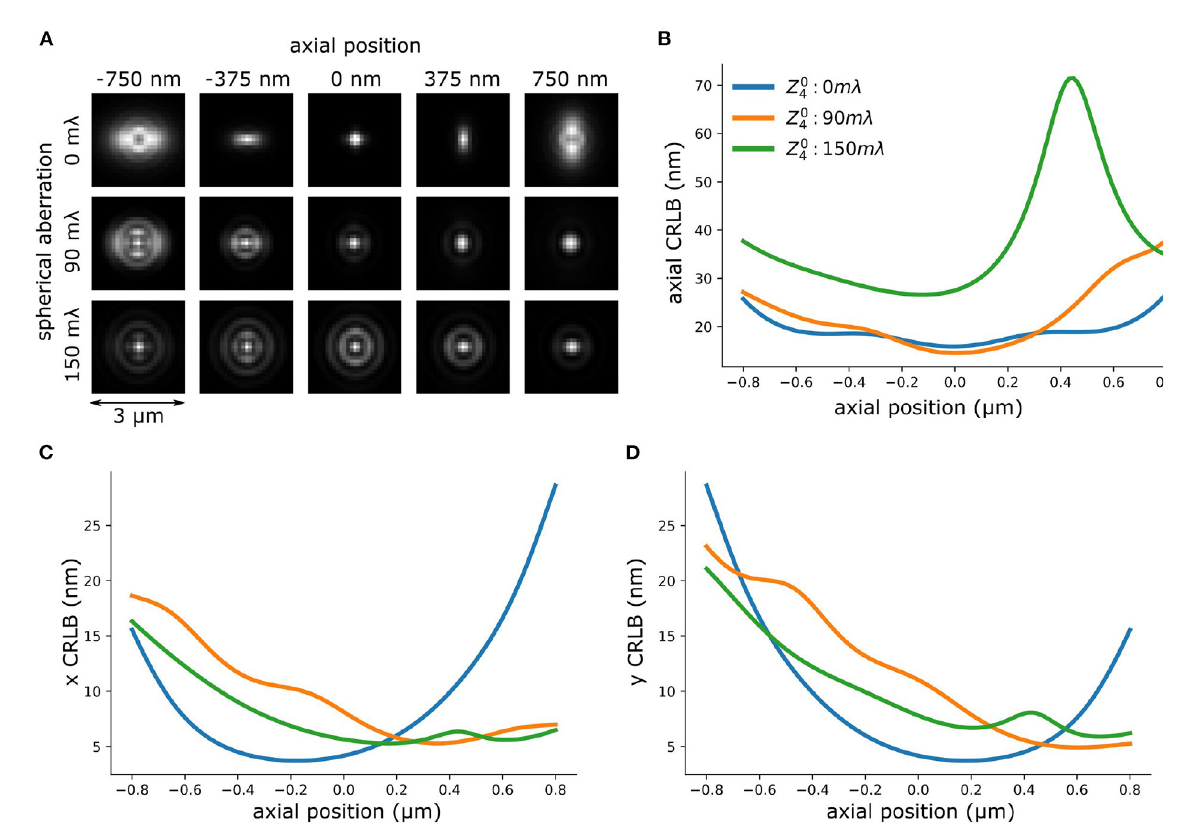
FIGURE8 Spherical aberration deteriorates axial CRLB of astigmatism-based PSF. (A) PSFs with different amplitude of spherical aberration. (B) Theoretical axial CRLB of INSPR PSF models with different amplitude of spherical aberration. (C,D) Theoretical lateral (x,y) CRLB of INSPR model with different amplitude of spherical